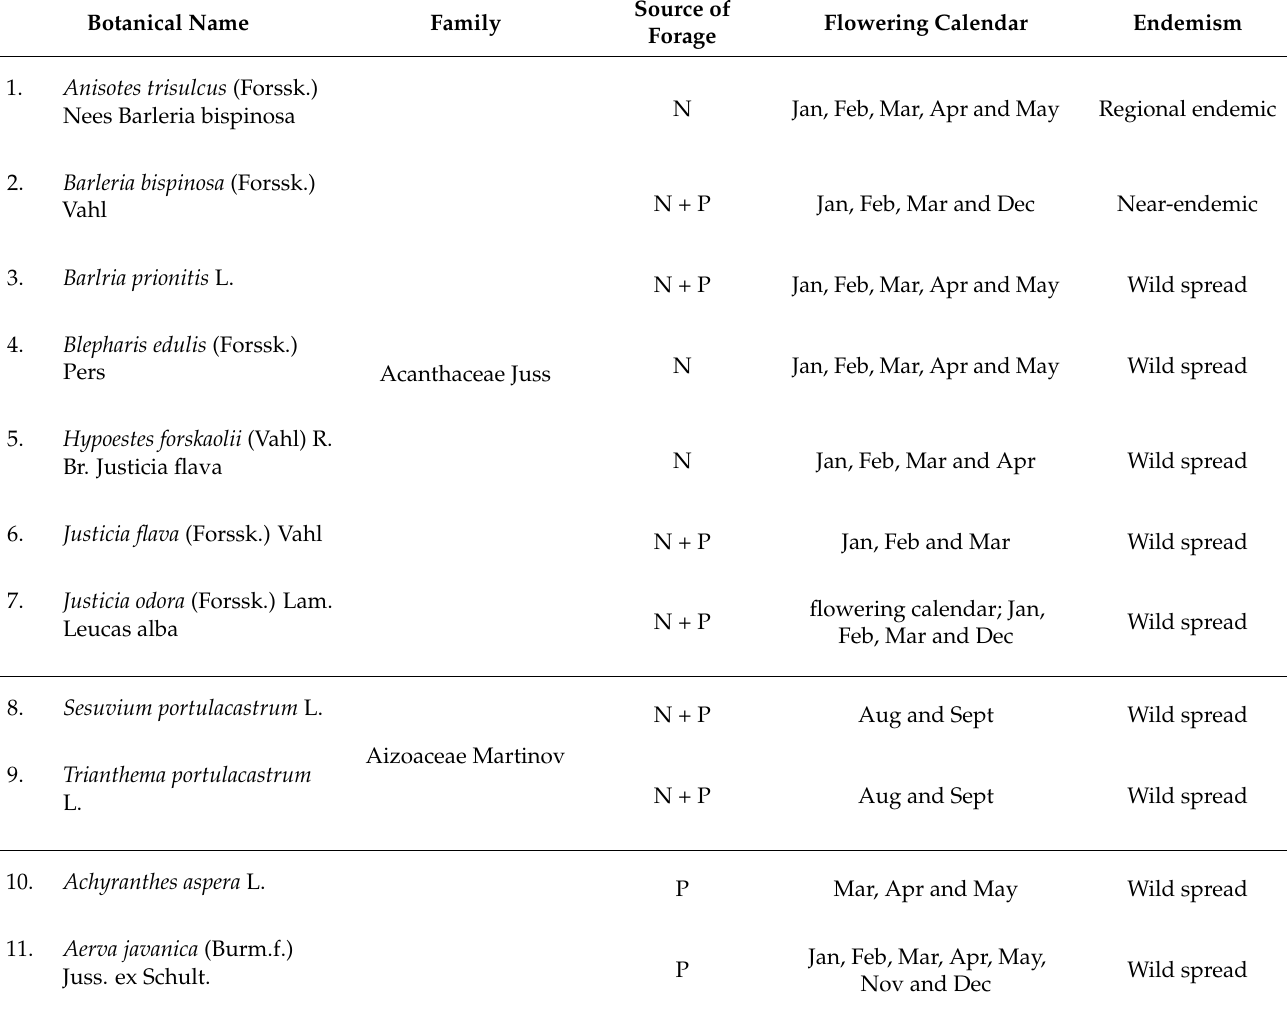
Table 2. Checklist of the bee forage plants from Al Baha, Southwestern Saudi Arabia. Nectar (N), Pollen (P), and Propolis